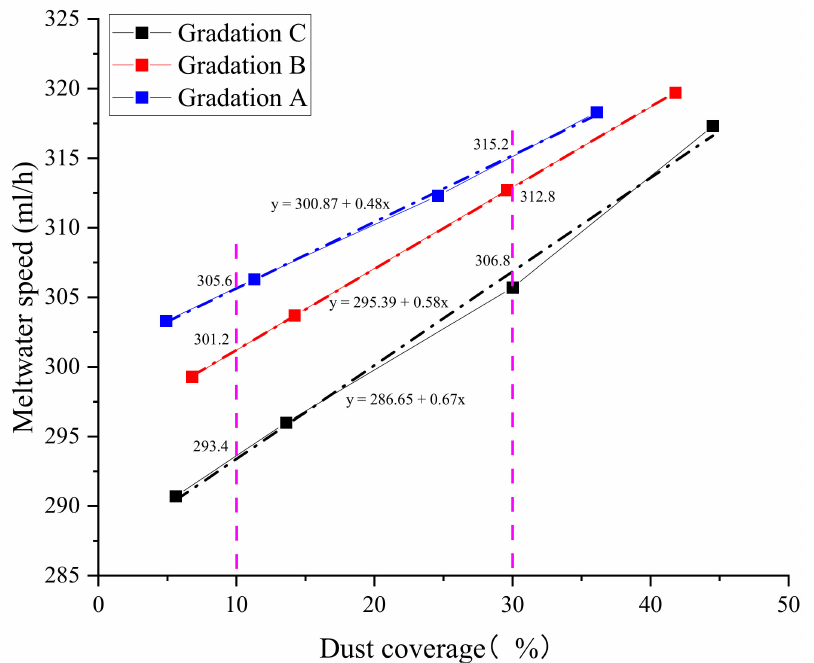
Figure 9. Relationship between the dust coverage rate and meltwater speed under different grading conditions, chain dotted lines are fitted curves of experimental data.